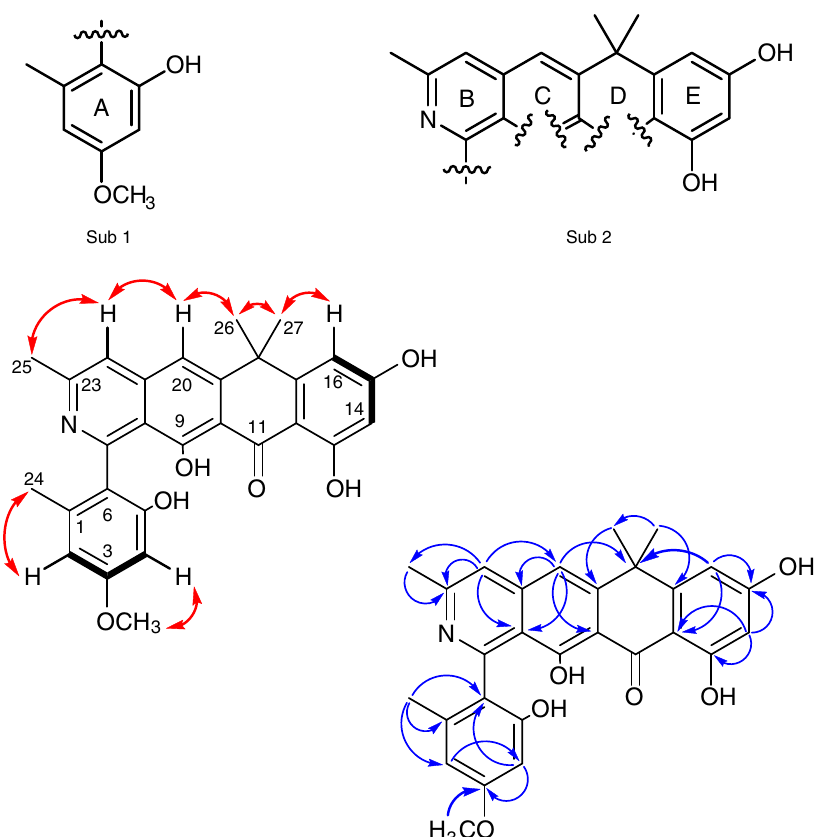
Fig. 3 Structure determination. The COSY (black bold), NOESY (red double headed arrows) and HMBC (blue single headed arrows) correlations for formicapyridine B ( 2 ), along with the two resulting substructures are shown (Sub 1 and Sub 2)